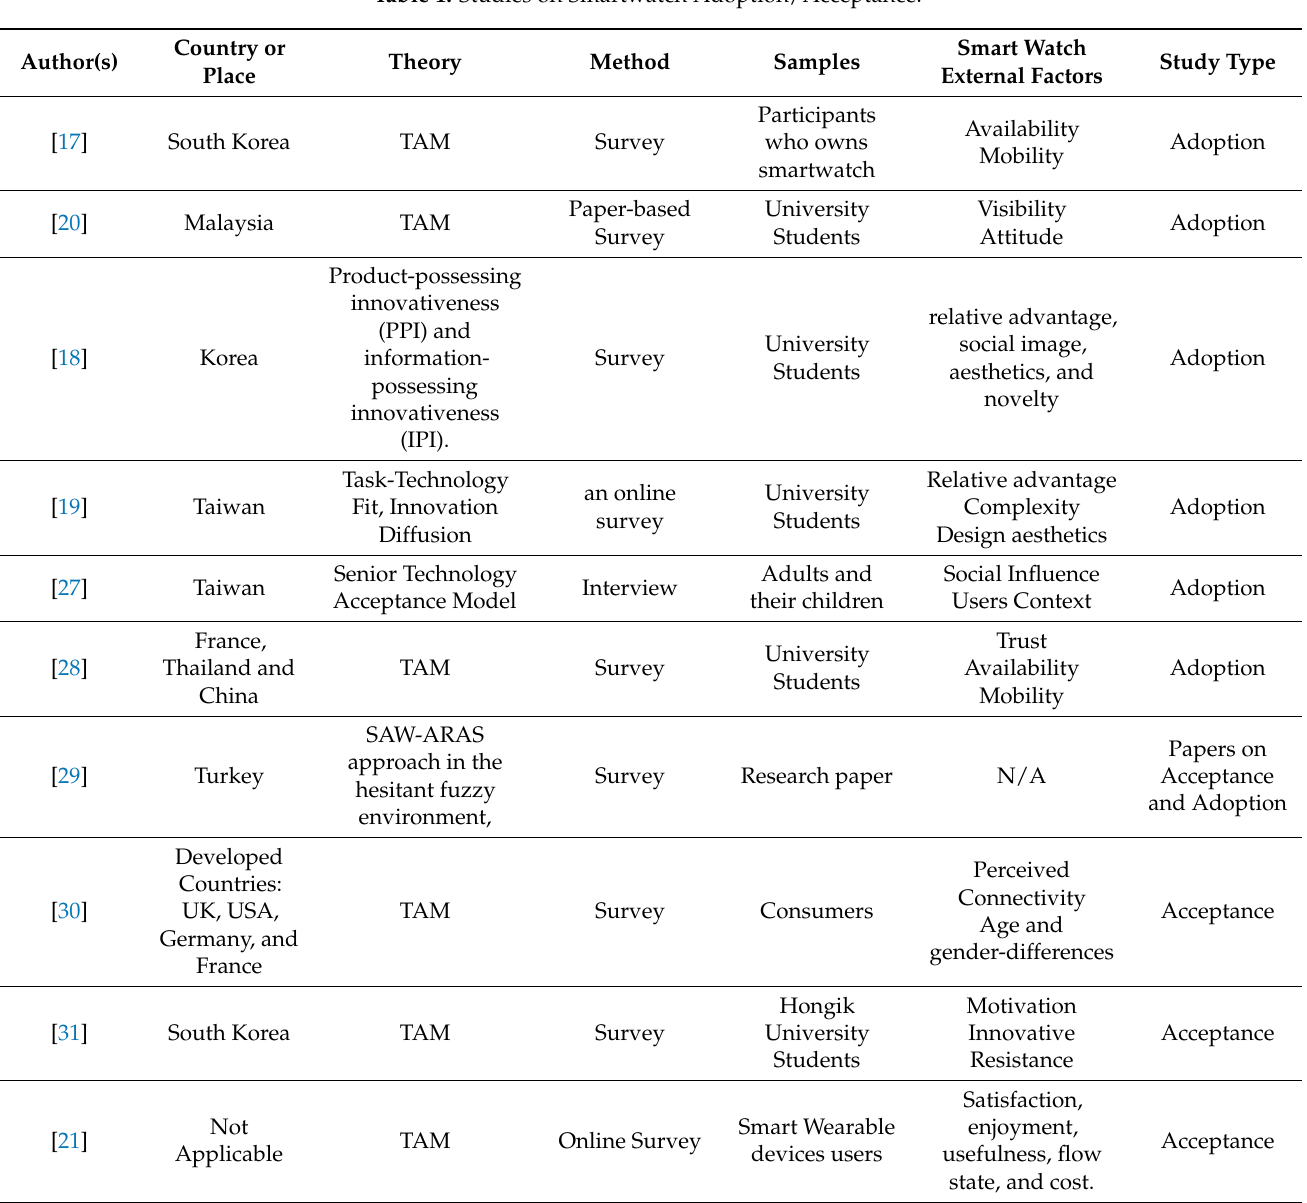
Table 1. Studies on Smartwatch